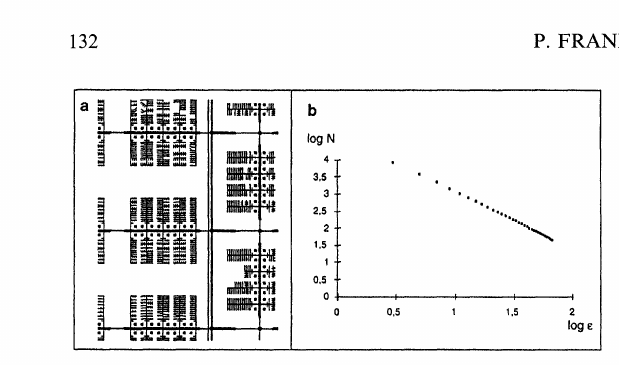
FIGURE 4 The plan of Hilberseimer for the reconstruction of Chicago. On the right hand the dilatation analysis of the structure. The slope of rather regular straight line corresponds to a dimension of D